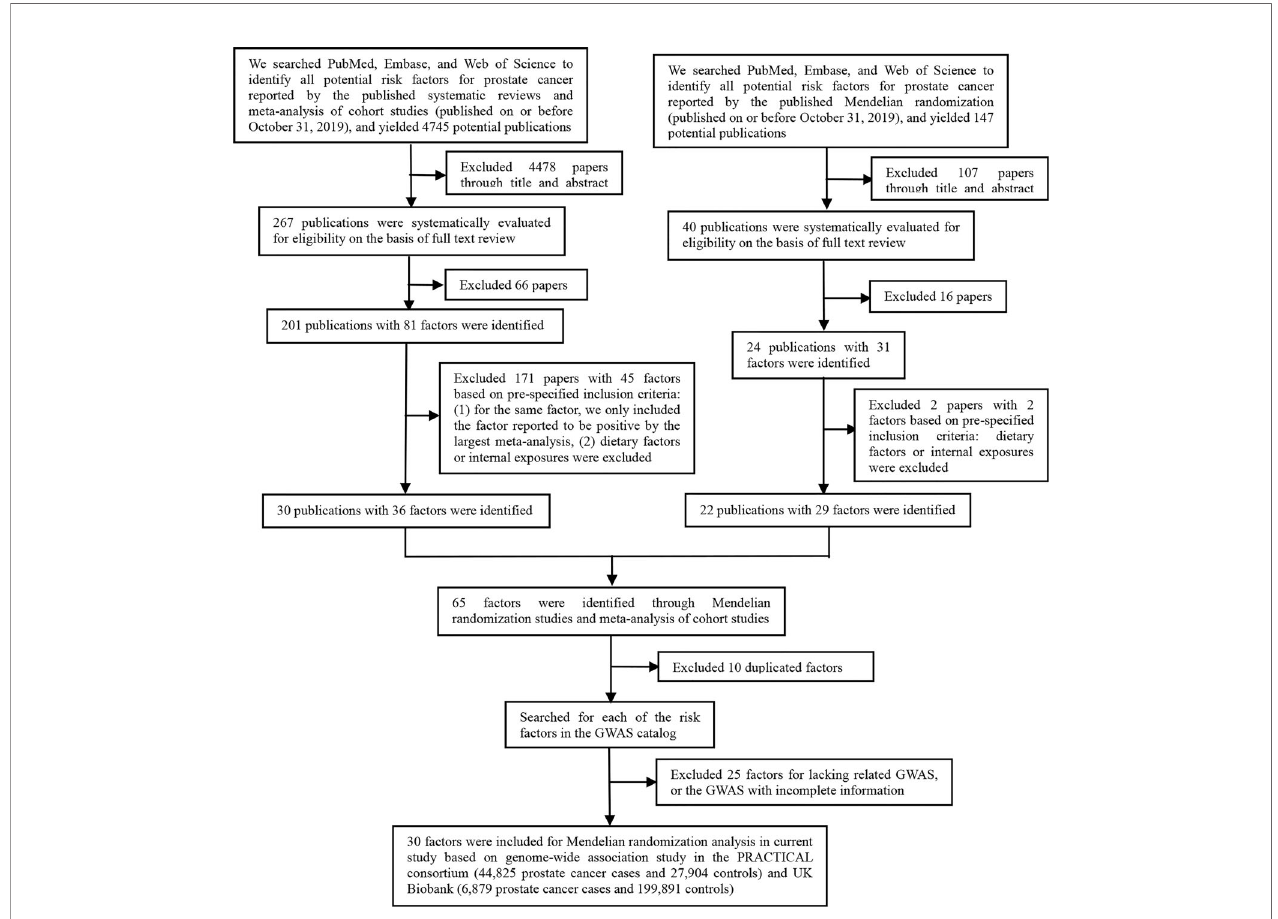
FIGURE 1 | The fl owchart of factors